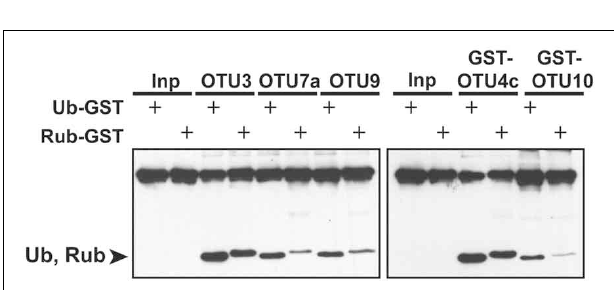
FIGURE 4 | The relative cleavage activities of A. thaliana OTU3, OTU4c, OTU7a, OTU9, and OTU10 for UB- and RUB-fused GST. The cleavage activities were analyzed using His-tagged OTU3, OTU7a, and OTU9 as well as His/GST-tagged OTU4c and OTU10. The substrates incubated without enzymes were used as negative input controls (Inp). The specific substrate used is indicated by “ + .” The cleavage products Ub and Rub, which are labeled on the left, and the inputs were visualized by immunoblotting with α